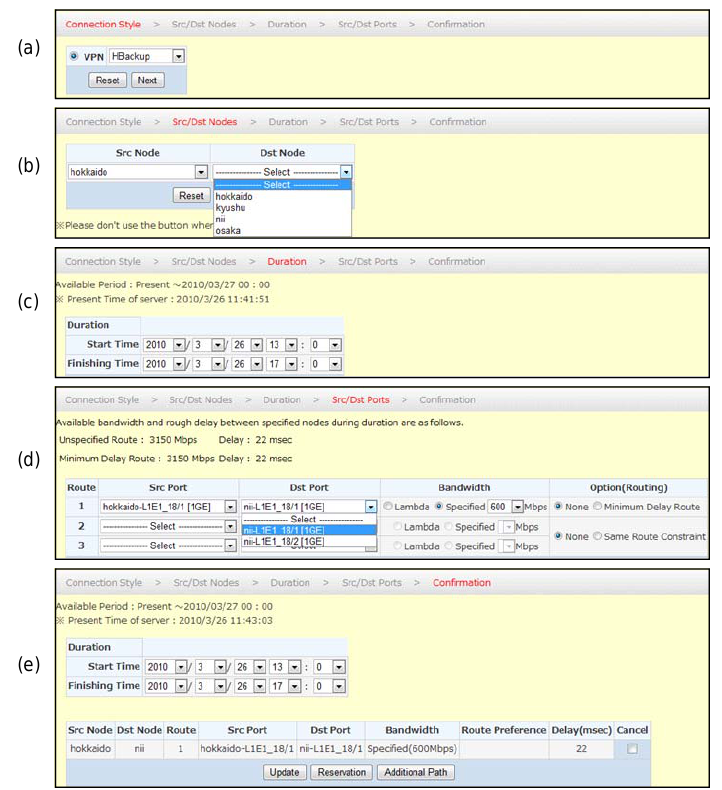
Figure 4. Sample Web screens for layer-1 BoD